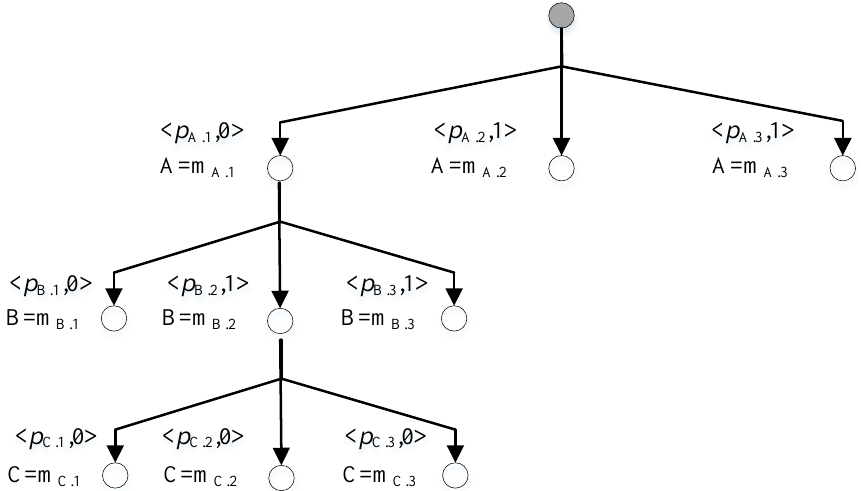
Figure 12. Search Tree of Global based A* Search.